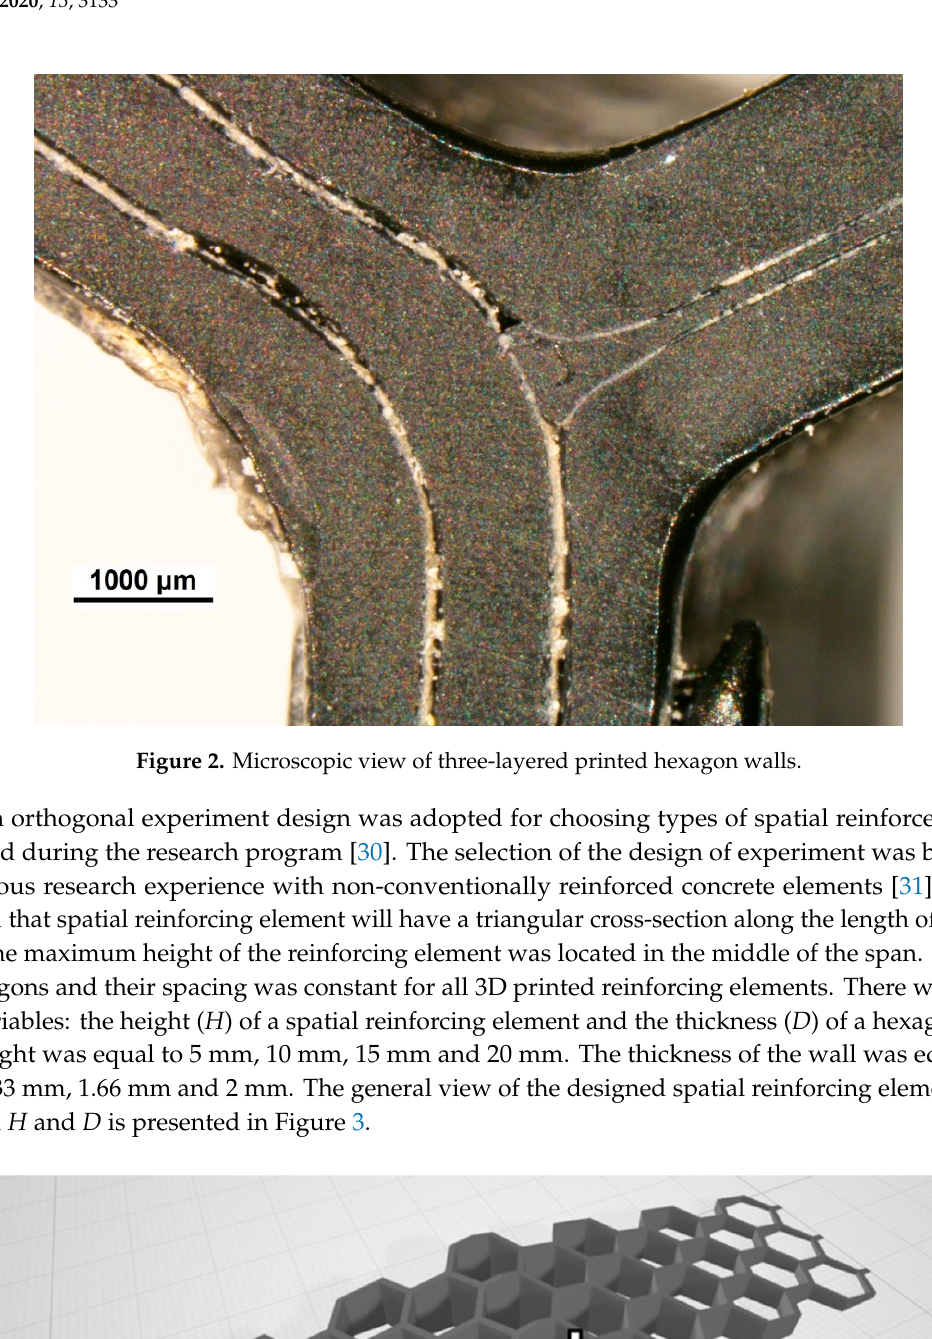
Figure 3. General view of the designed spatial reinforcing element.